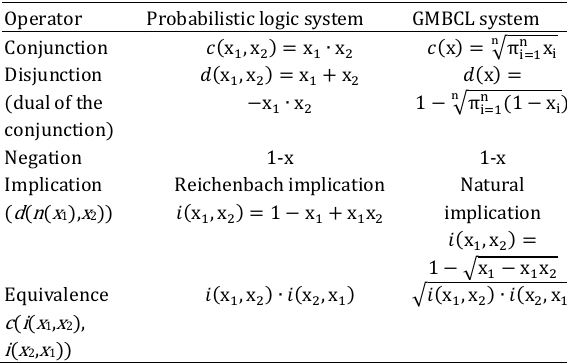
Table 1. Operators of the probabilistic